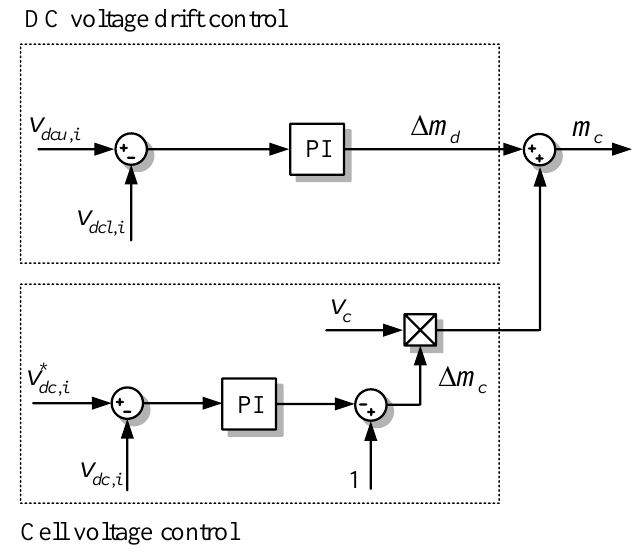
Figure 6. Implemented voltage balancing control strategy per 3L-TNPC cell.